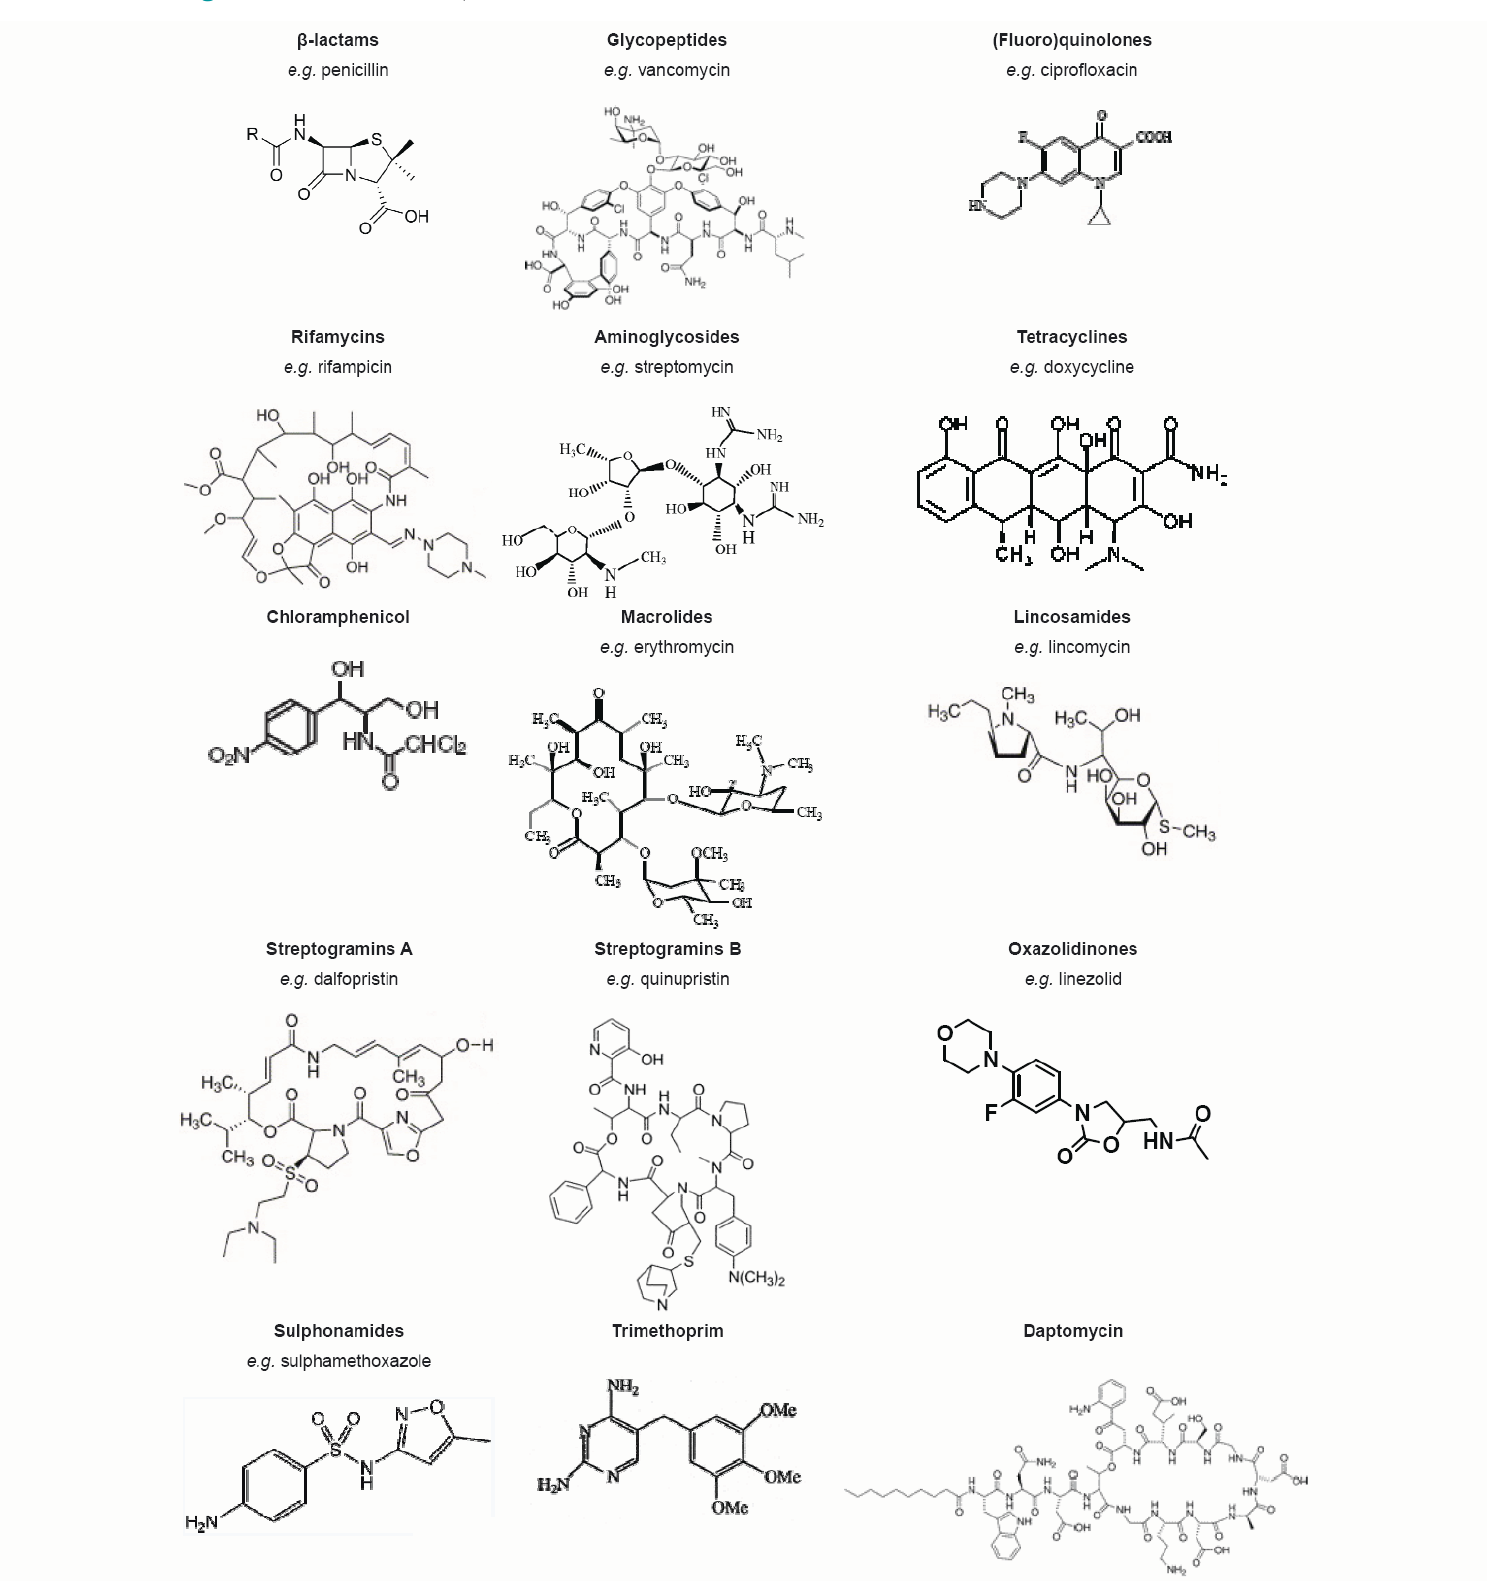
Figure 3. Structures of some representatives for the discussed antimicrobial